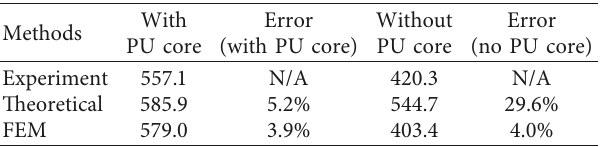
Table 2: Critical buckling loads of the test specimens.